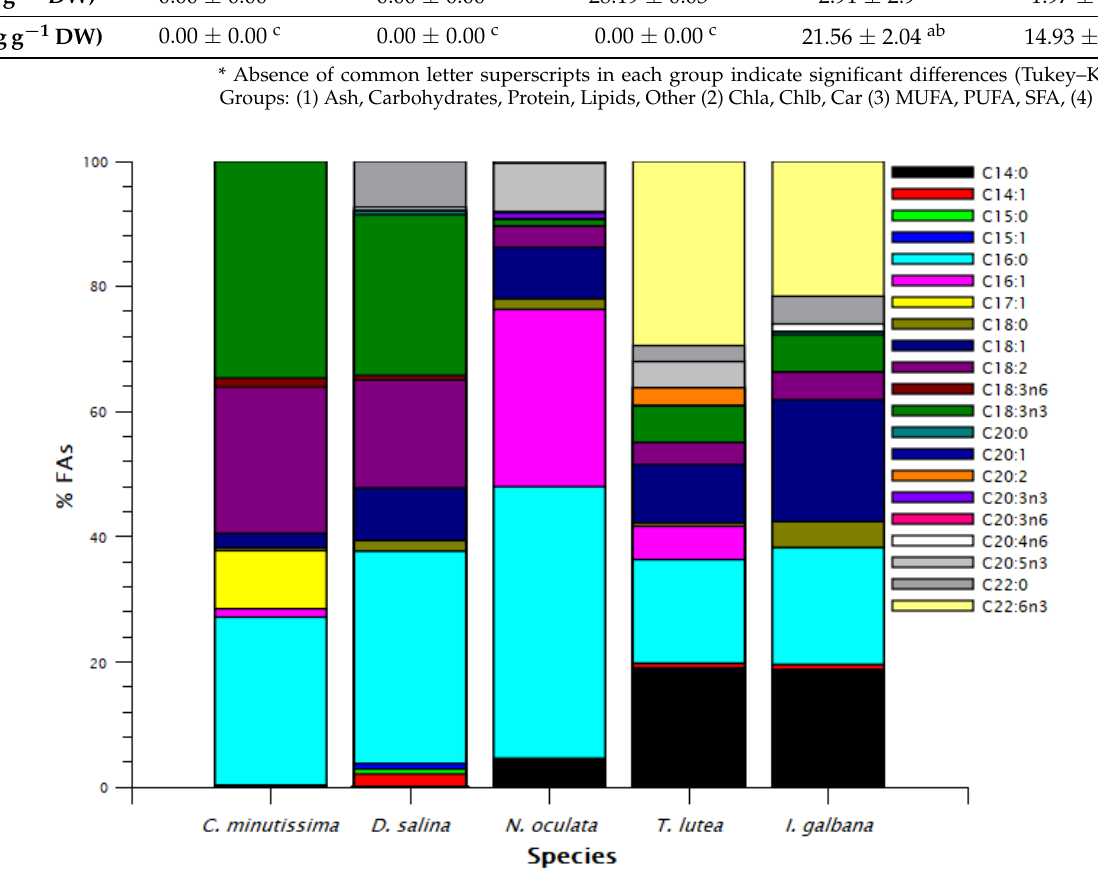
Figure 3. FA profile during the late stationary phase. Concentrations of FAs are expressed as per- centage of total FAs. percentage of total